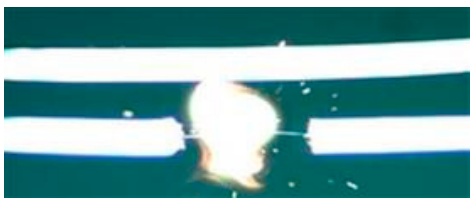
Figure 12. Arc observed at the time of breakage of an element conductor.